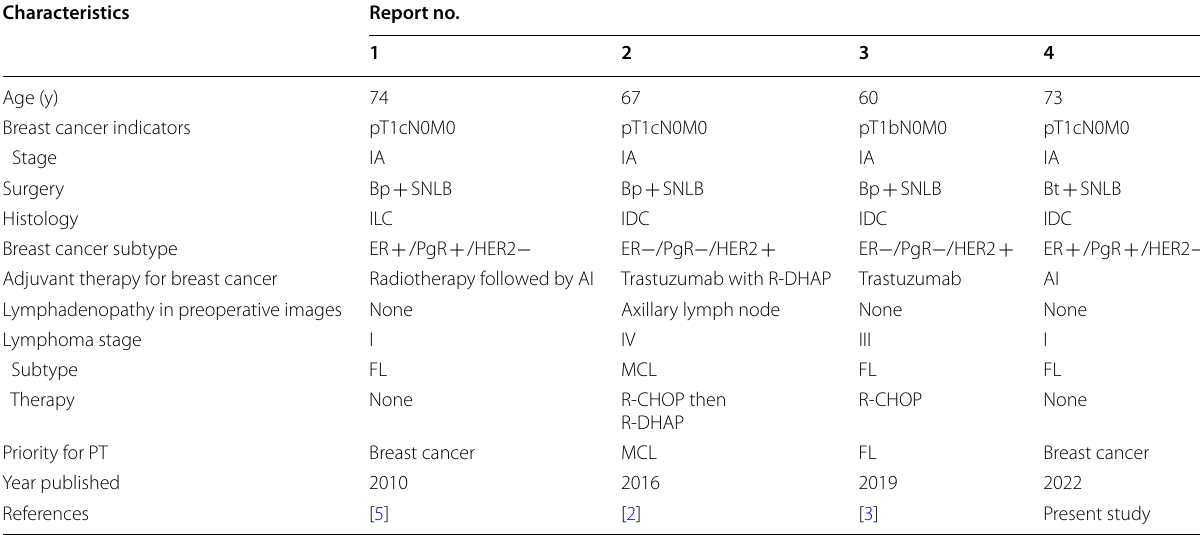
AI aromatase inhibitor, Bp breast partial mastectomy, Bt breast total mastectomy, FL follicular lymphoma, HER2 human epidermal growth factor receptor type2, IDC invasive ductal carcinoma, ILC invasive lobular carcinoma, MCL mantle cell lymphoma, PT postoperative treatment, R-CHOP rituximab, cyclophosphamide, doxorubicin hydrochloride, oncovin, and prednisolone, R-DHAP rituximab, dexamethasone, high-dose ara-C, cytarabine, and cisplatin, SNLB sentinel lymph node biopsy, TNBC triple-negative breast